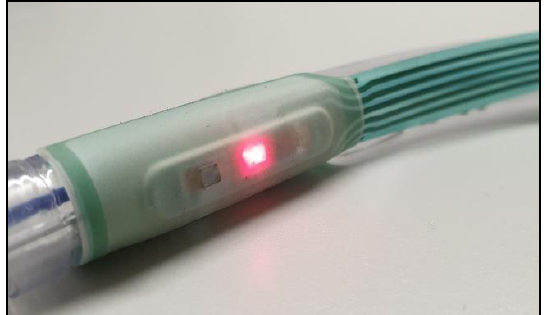
Figure 3. The ET Sensor attached to a standard adult size 7 ET Tube.